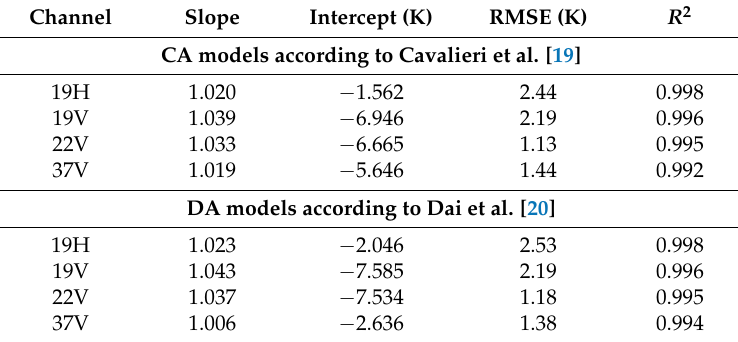
Table 3. The regression coefficients of the calibration models ( Y = Slope × X + Intercept) of inter-sensor bias correction using F13 as the baseline. Channel Slope Intercept (K) RMSE (K) R 2 CA models according to Cavalieri et al. [19]